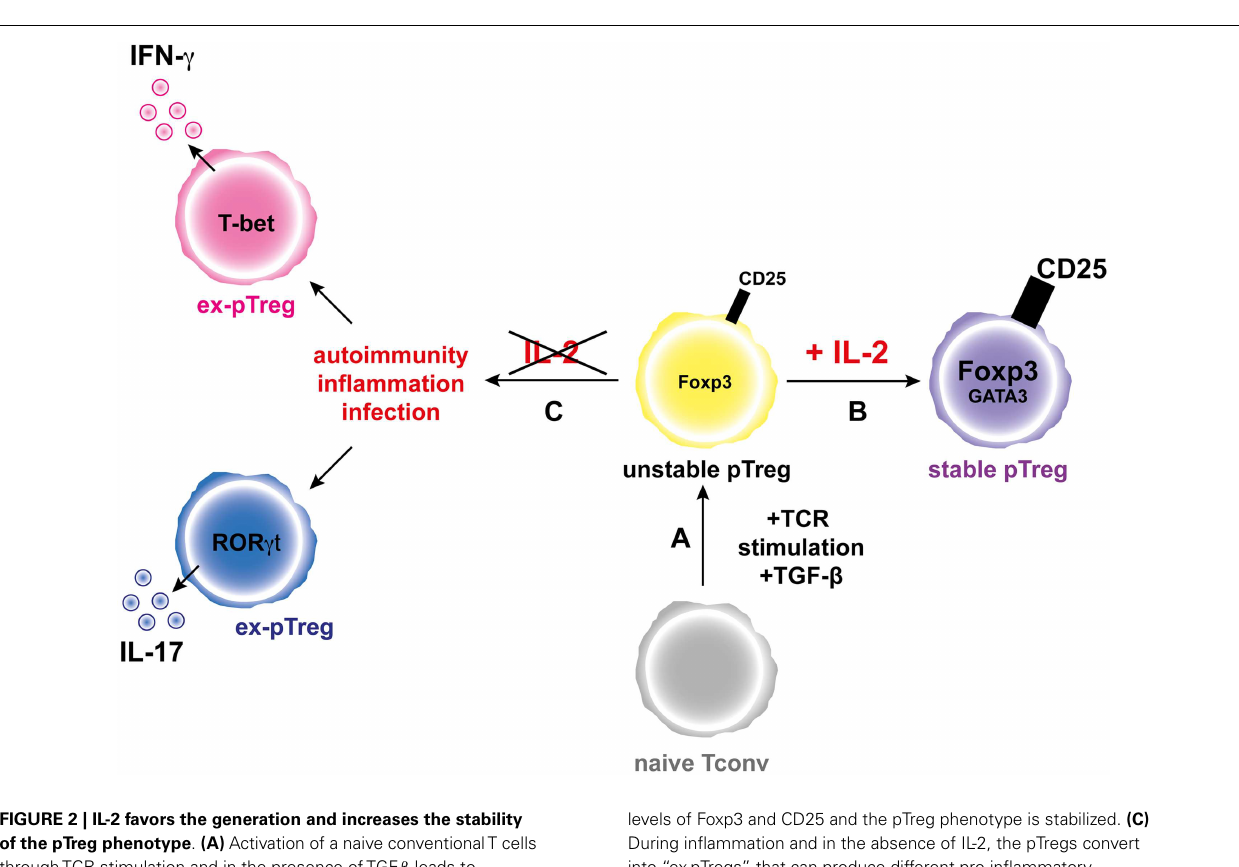
FIGURE 2 | IL-2 favors the generation and increases the stability of the pTreg phenotype . (A) Activation of a naive conventionalT cells throughTCR stimulation and in the presence ofTGF- β leads to generation of unstable pTregs that express moderate levels of Foxp3 and CD25. (B) In the presence of IL-2, pTregs increase the expression